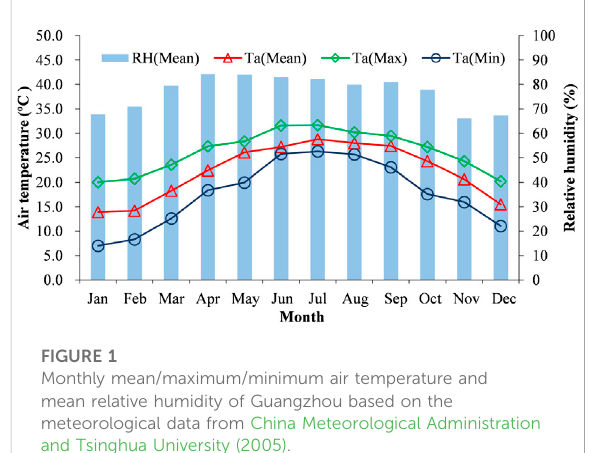
FIGURE 1 Monthly mean/maximum/minimum air temperature and mean relative humidity of Guangzhou based on the meteorological data from China Meteorological Administration and Tsinghua University (2005).